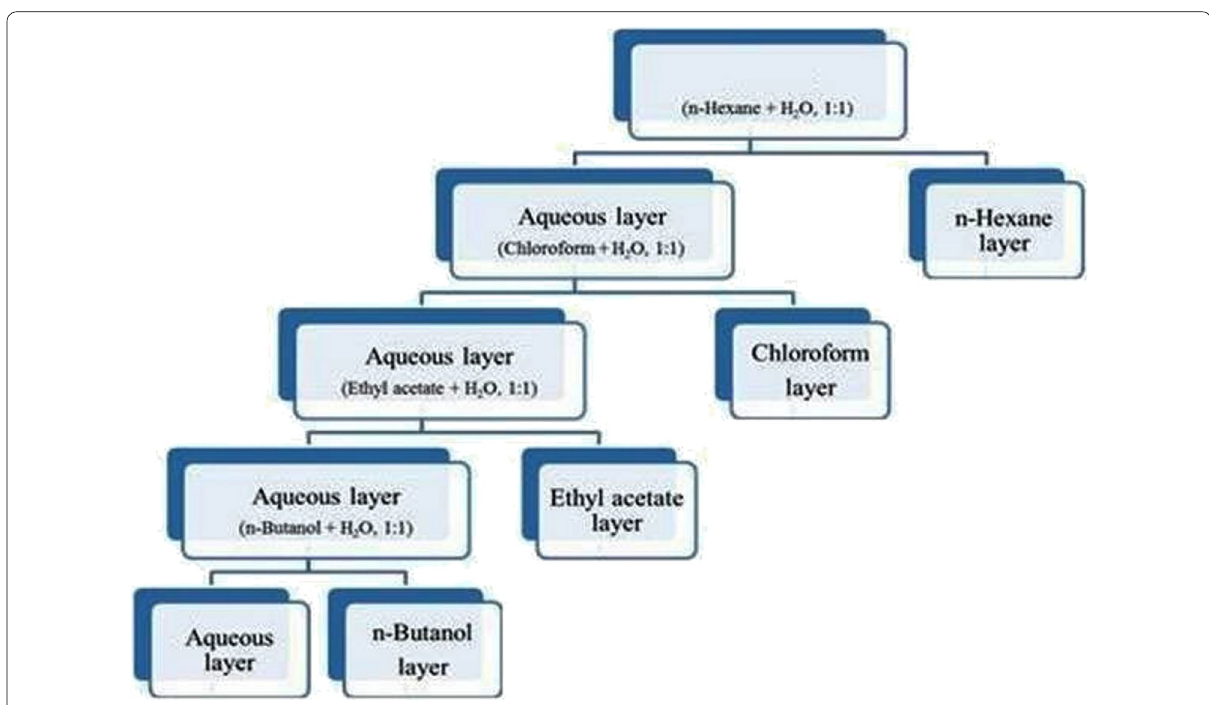
Fig. 3 Stepwise extraction